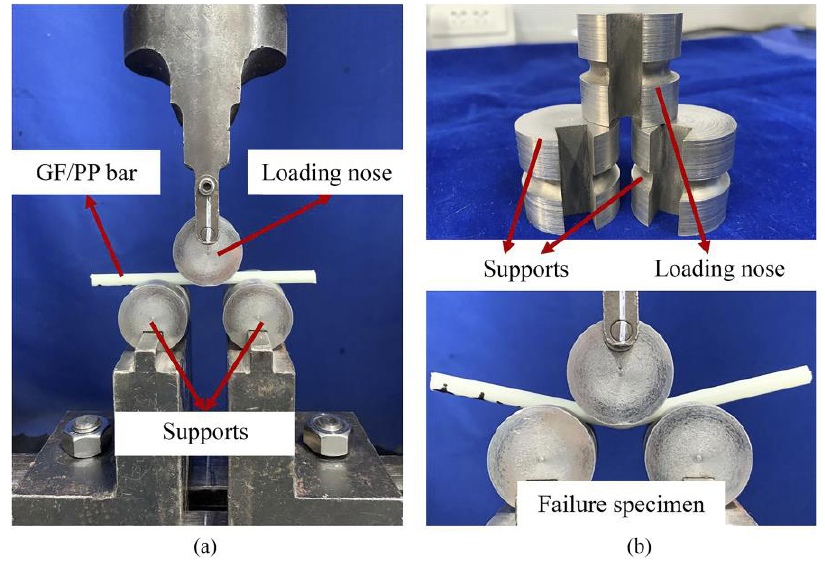
Figure 11. Test setup for flexural testing of pultruded thermoplastic Ø 6mm GF/PP bars based on inhouse made PCTs: ( a ) flexural testing; ( b ) failure specimen.